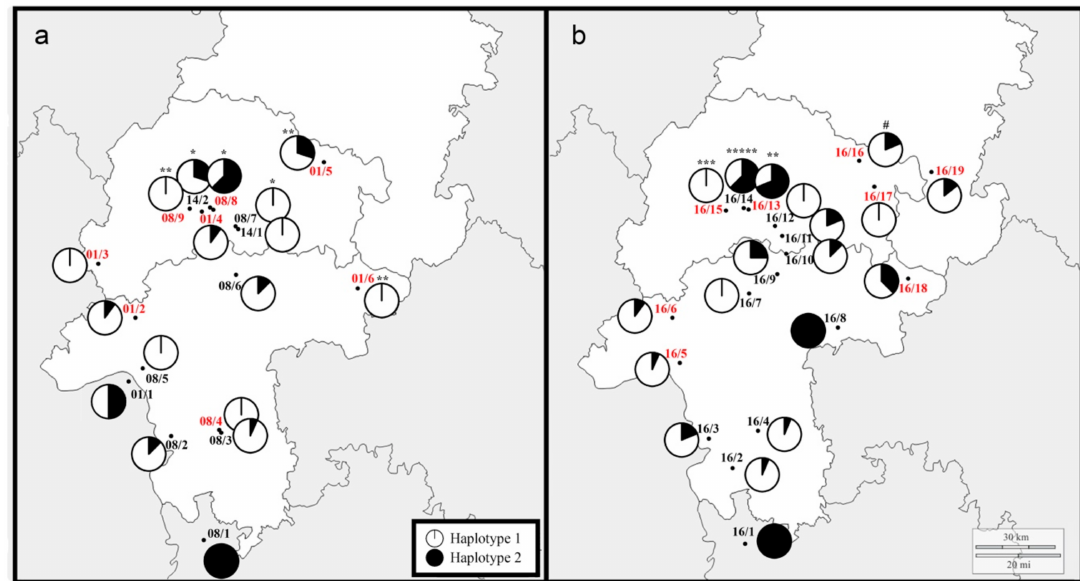
Figure 2. ( a ) Prevalence of haplotypes between 2001 and 2014 and ( b ) in 2016. White = proportion of individuals associated with HT1, black = proportion of individuals with HT2. Asterisks represent number of w Cer2-infected individuals associated with HT1, whereas the pound represents the only individual that was w Cer2-uninfected but associated with